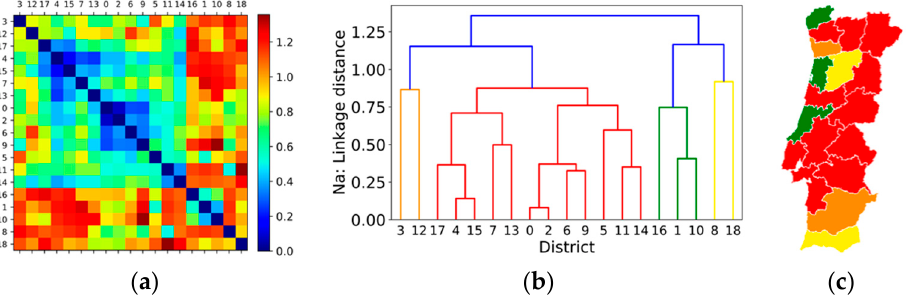
Figure 14. Natural causes (Na): ( a ) Dissimilarity matrix; ( b ) Clusters by relative annual profile of distribution; ( c ) Clusters in geographic location (cophenetic coefficient: 0.81).